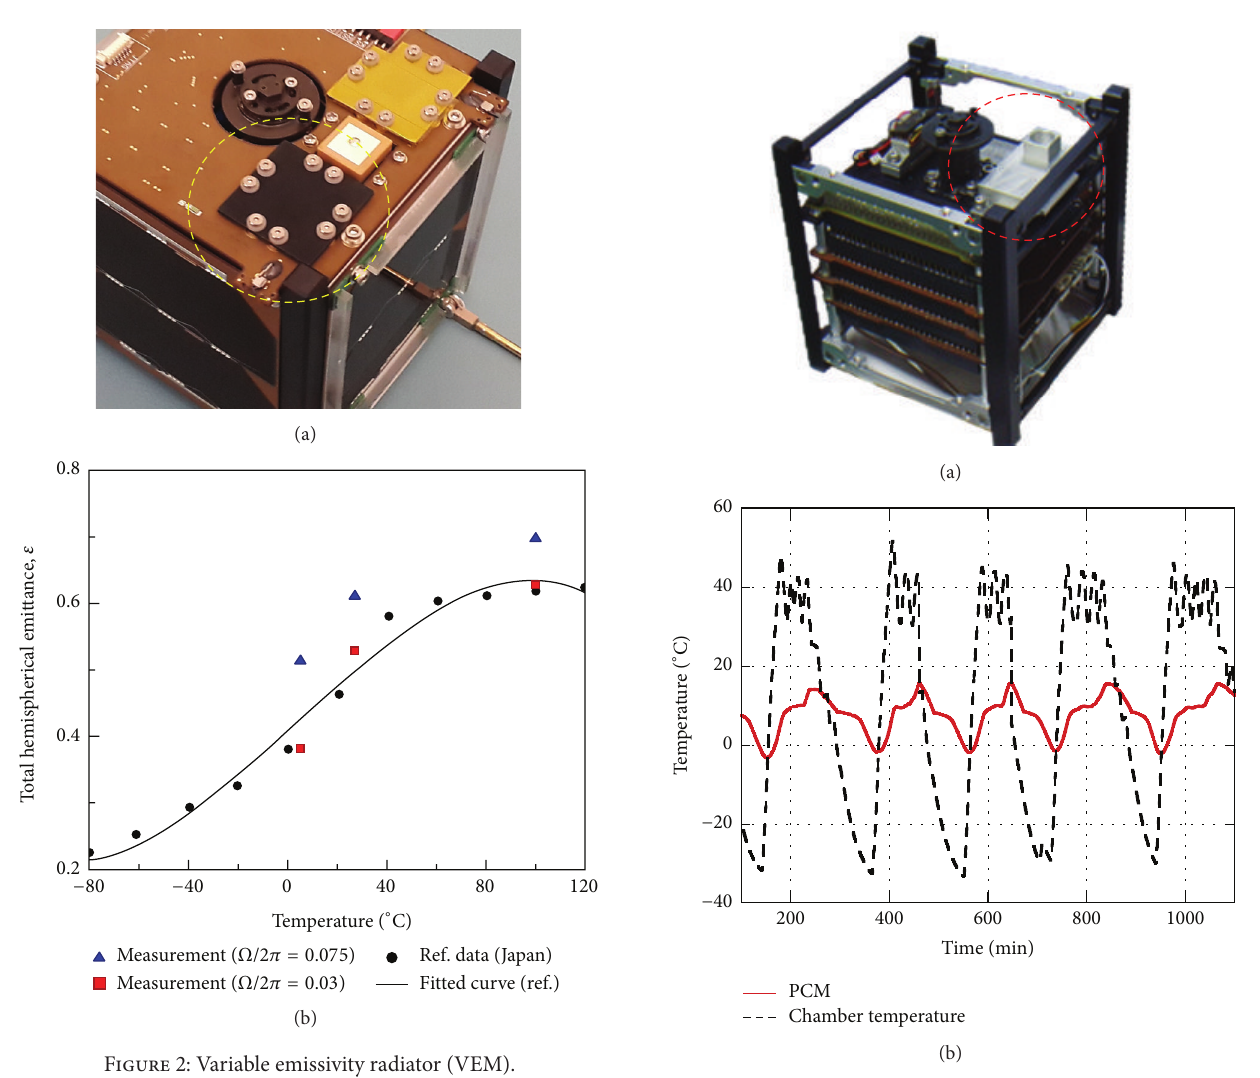
Figure 3: Phase change material